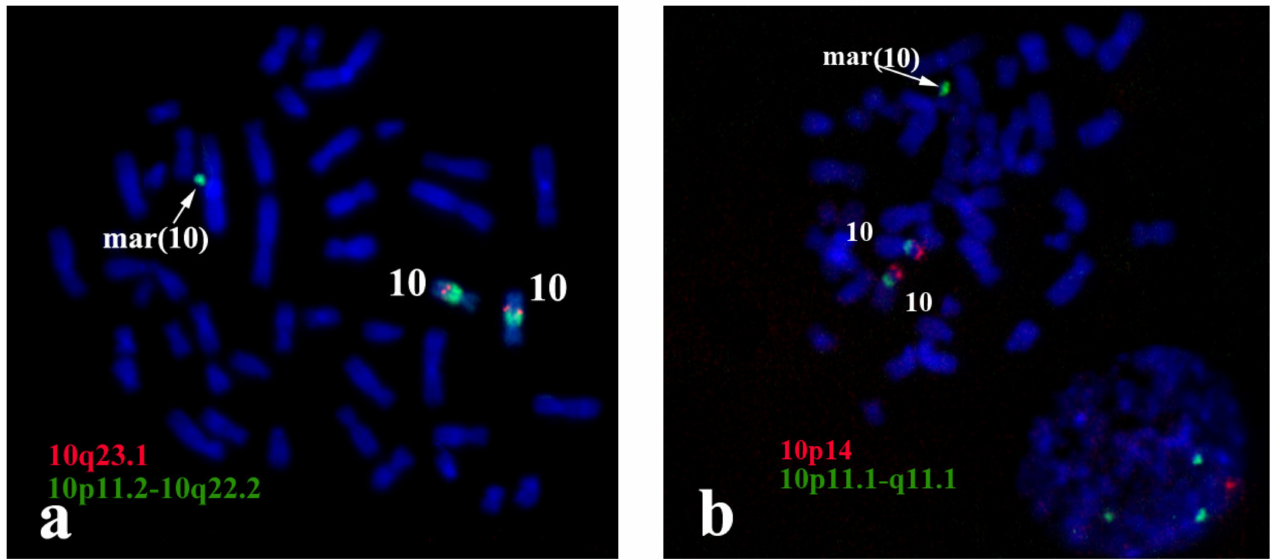
Figure 3. Painting with PCP10q- and FISH with locus-specific DNA probes on foetal metaphase chromosomes. DAPI staining is blue. ( a ) Painting with PCP10q- (green signals) and FISH with BAC clone RP11-225E2 (red signals); ( b ) FISH with D10Z1 (green signals) and CELF2/BRUNOLS3 (red signals)